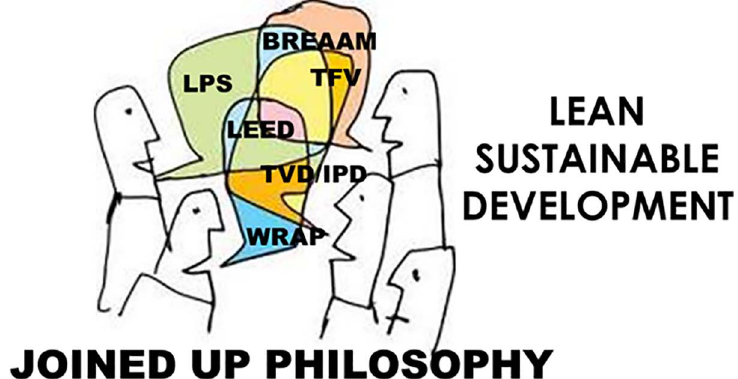
Figure 2. Towards a joint up philosophy for integrating lean and sustainable construction (adapted from Sarhan, et al., 2019; courtesy: Christine